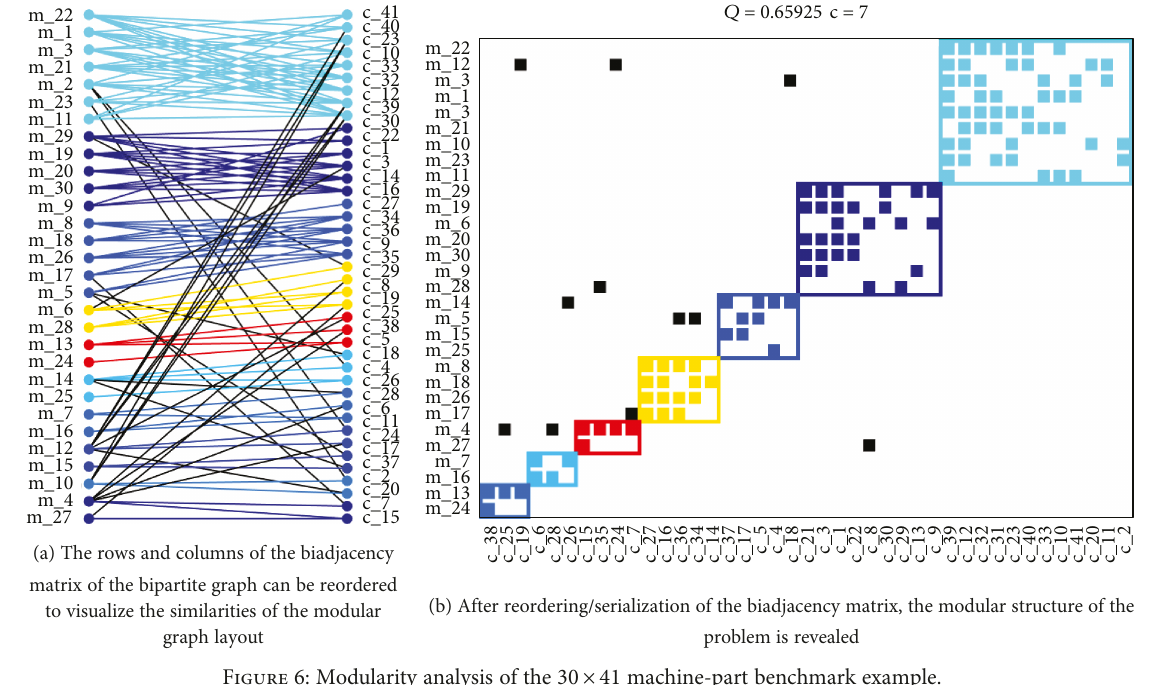
Figure 6: Modularity analysis of the 30 × 41 machine-part benchmark Table 6: Cell formation e ffi ciency of bipartite modularity optimization algorithms. The Γ values are given as rounded percentages. Optimization [46] Newman Problem size